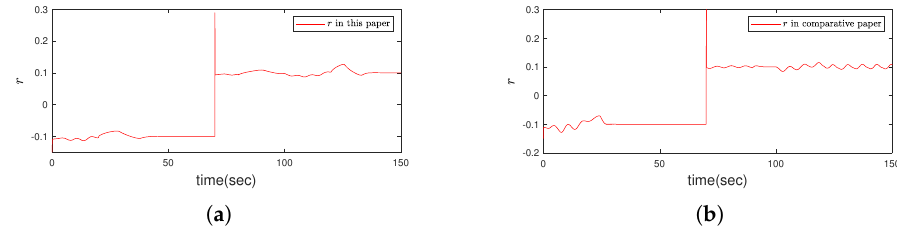
Figure 5. ( a ) The response curve for yaw angle velocity r in this paper. ( b ) The contrastive curve for yaw angle velocity r in method that ignores the effect of thruster saturation in [15].